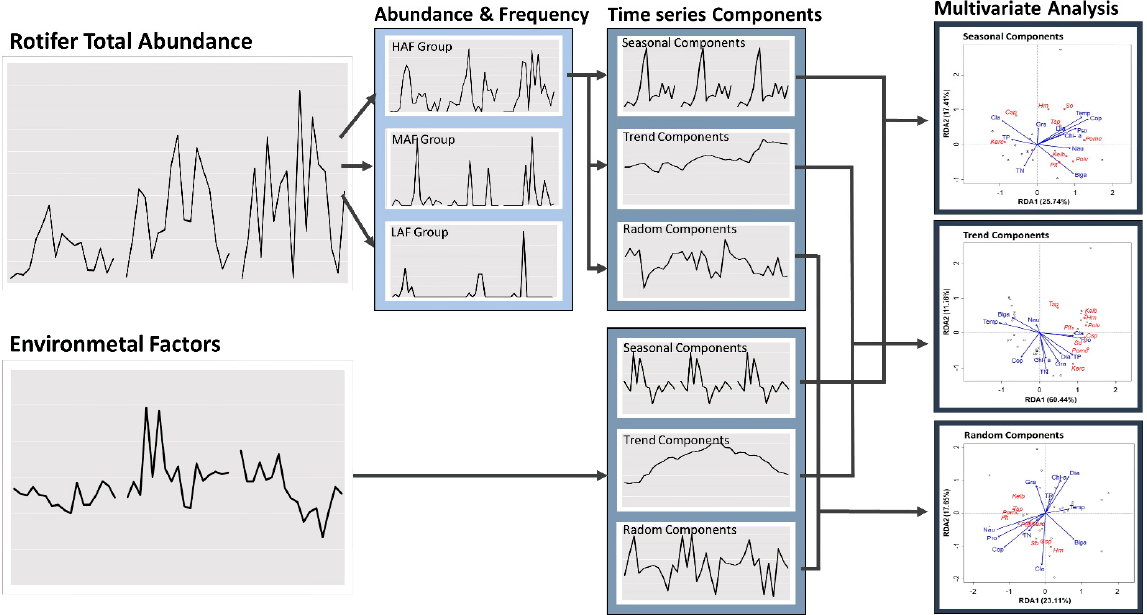
Figure 2. Time series data to elucidate the relationship between the abundance patterns of rotifers and environmental